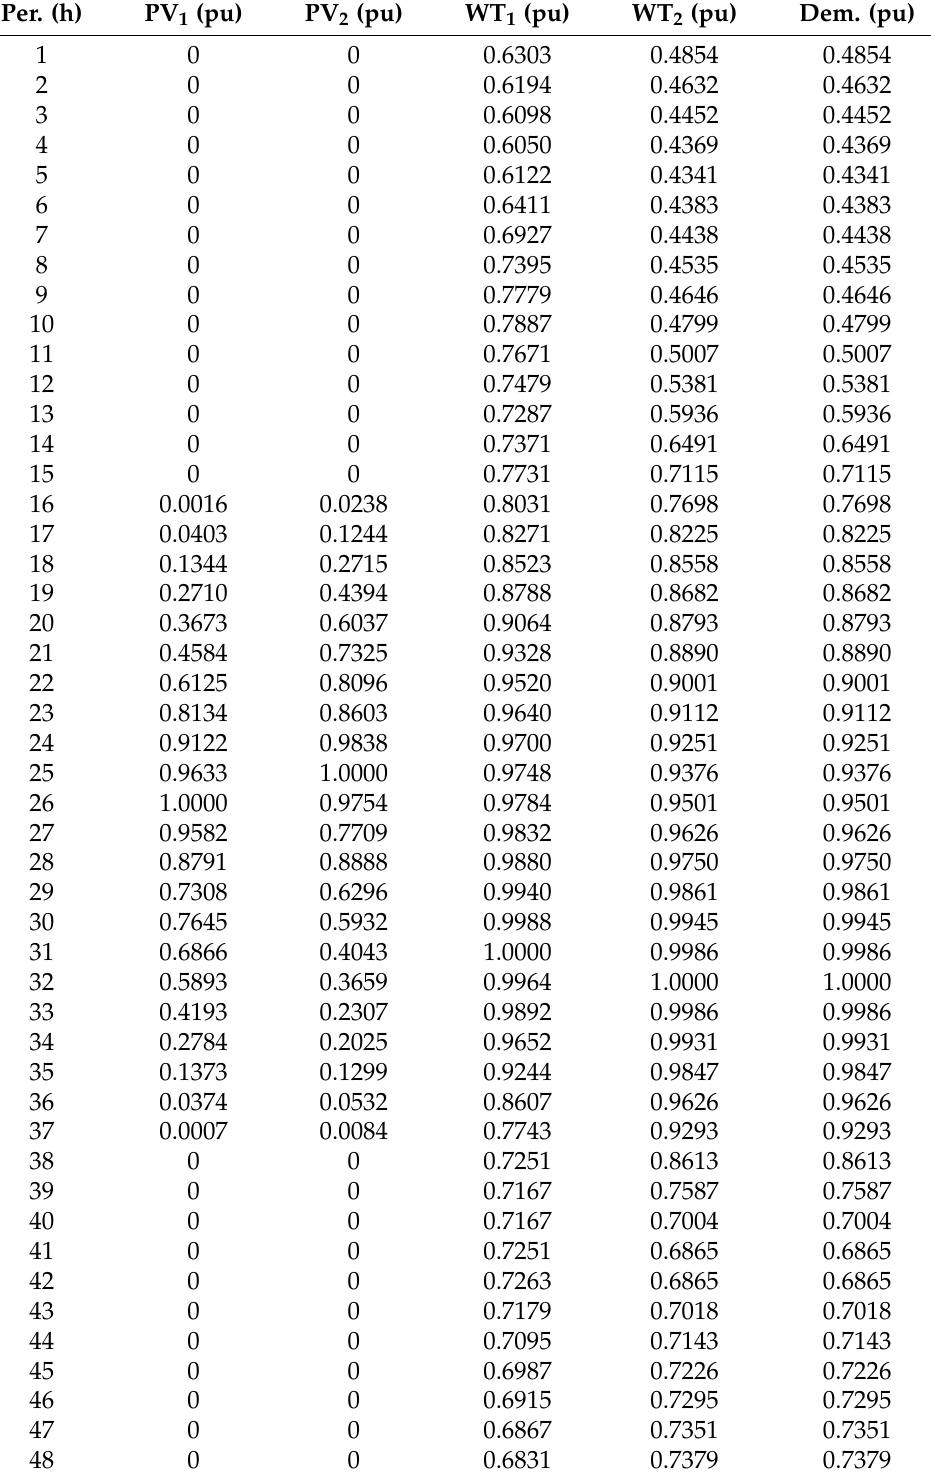
Table 2. Solar and wind generation data for each time